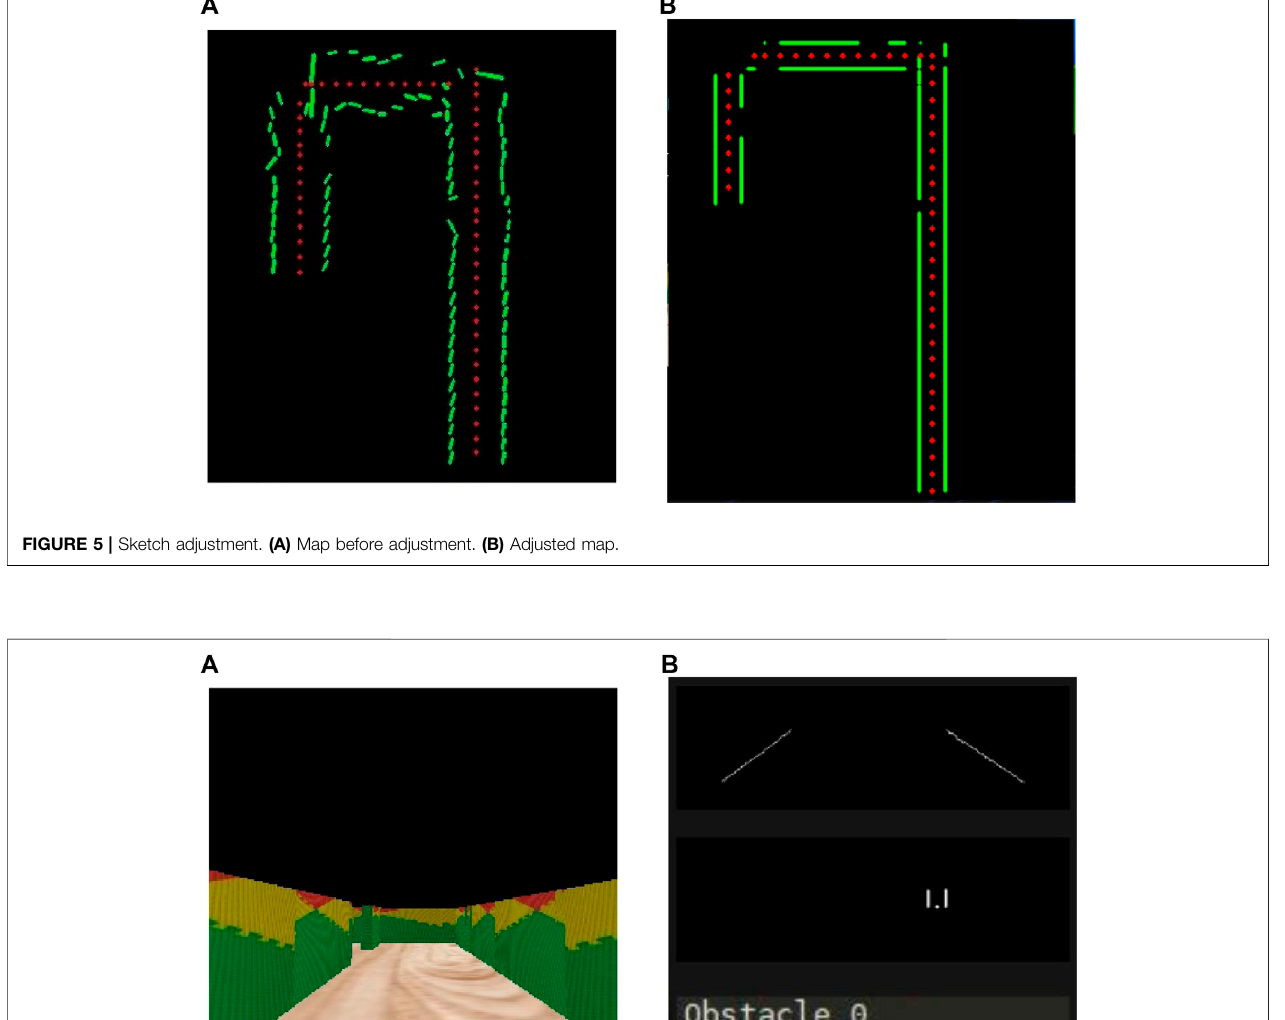
Frontiers in Robotics and AI |